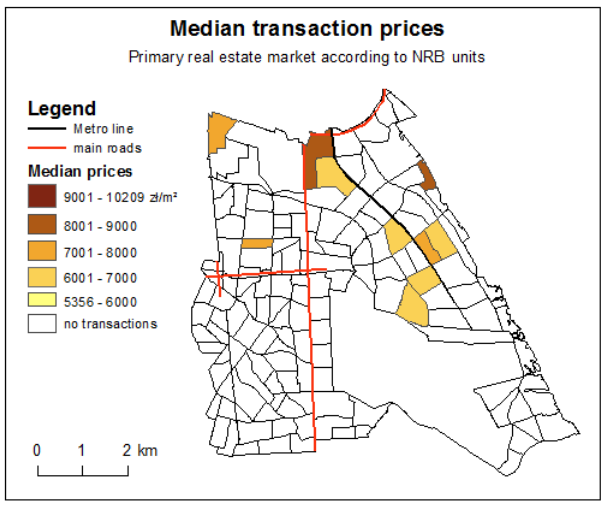
Fig. 8. Average prices of residential premises on the primary real estate market in Ursynów, according to cadastral